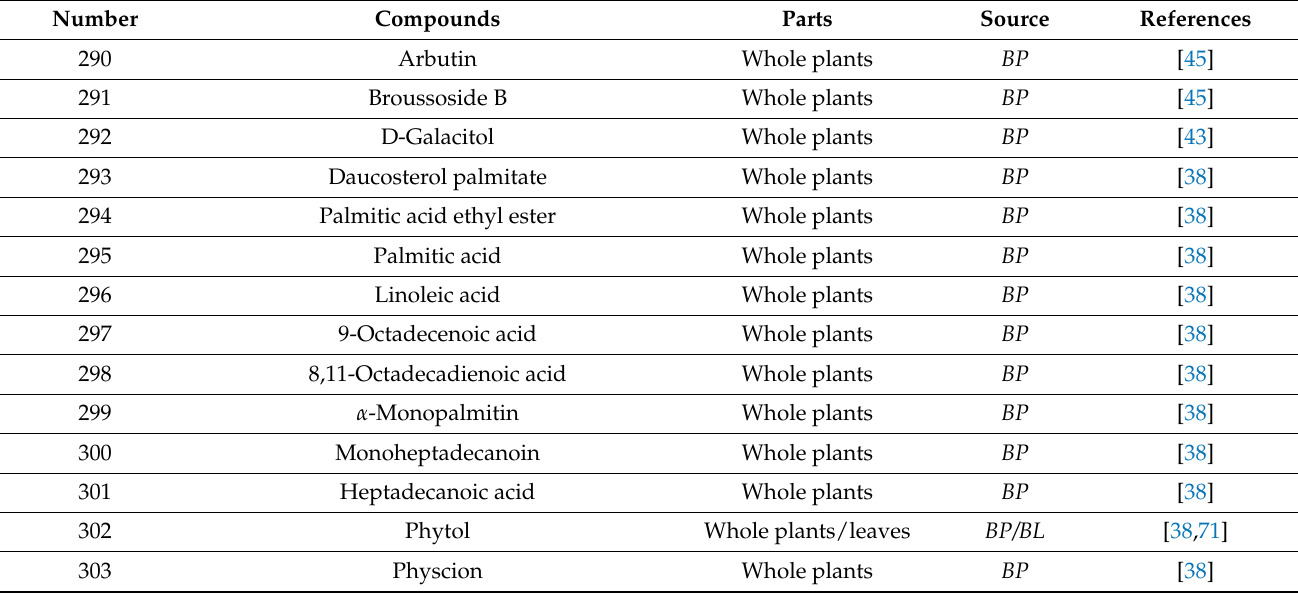
Table 7. Other compounds isolated from Broussonetia